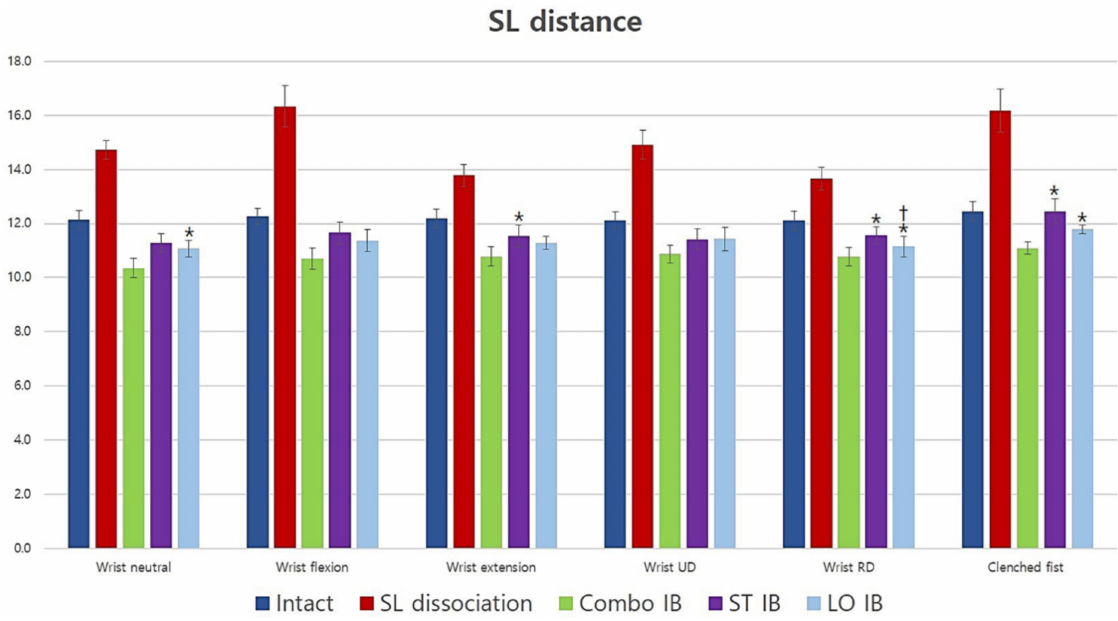
Figure 5. Average scapholunate distance for all conditions and positions (mm). Short-transverse and long-oblique IB had similar effects; however, both were less effective than Combo IB. *: Statistically significant difference compared to Combo IB ( p < 0.05), †: Statistically significant difference compared with short-transverse IB ( p < 0.05). SL: scapholunate; UD: ulnar deviation; RD: radial deviation; Combo: combination; IB: internal bracing; ST: short-transverse; LO: